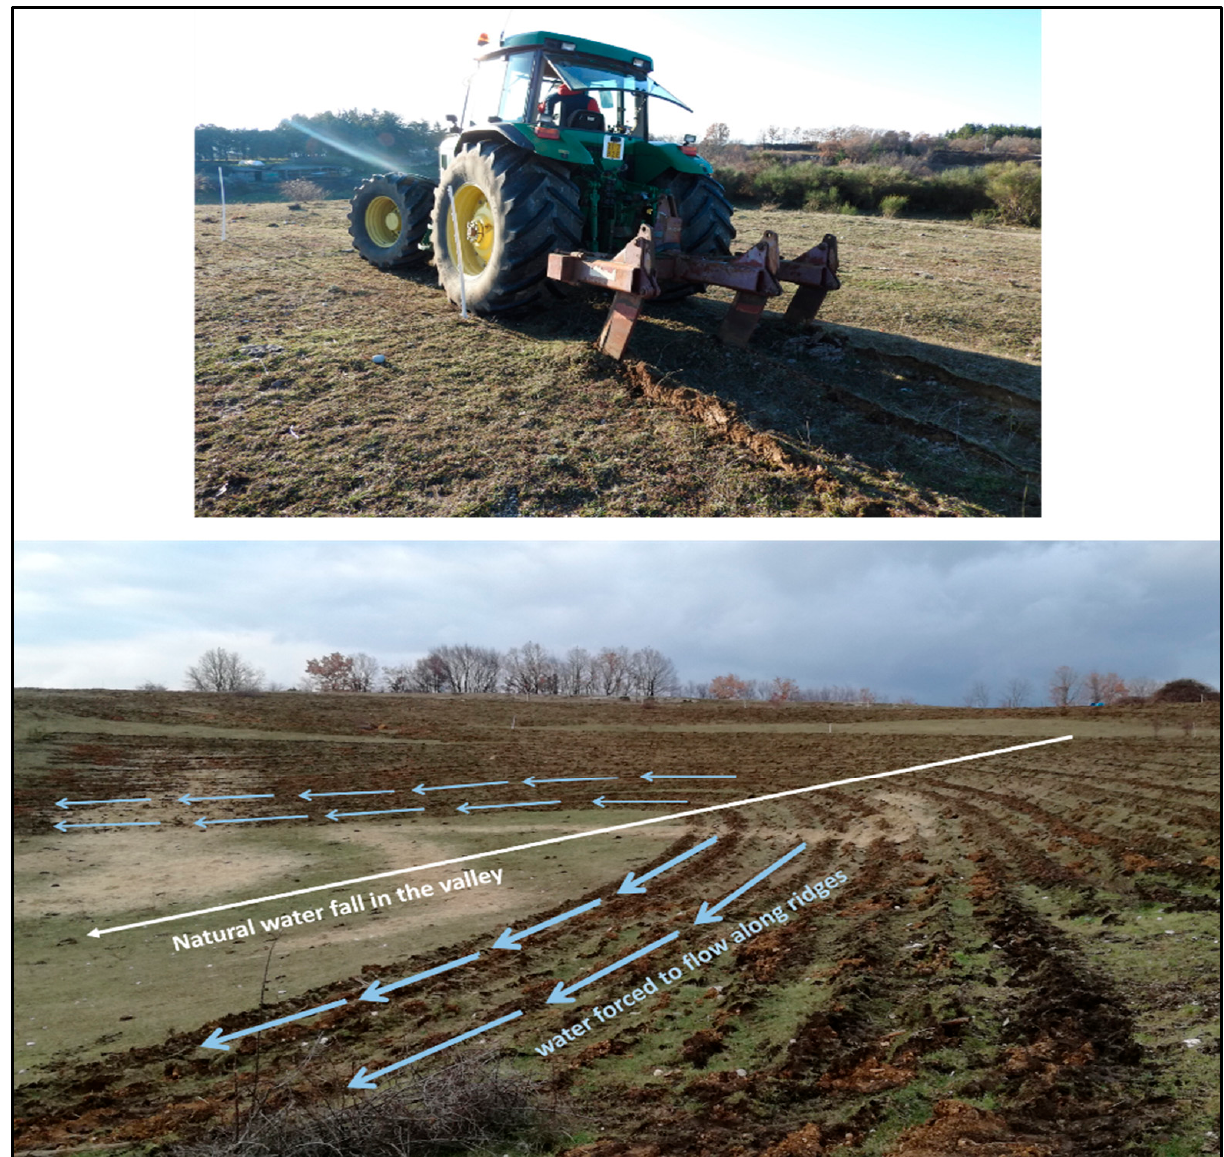
Figure 2. Example of tillage using a soil aerator ripper in pasture and following keyline design.